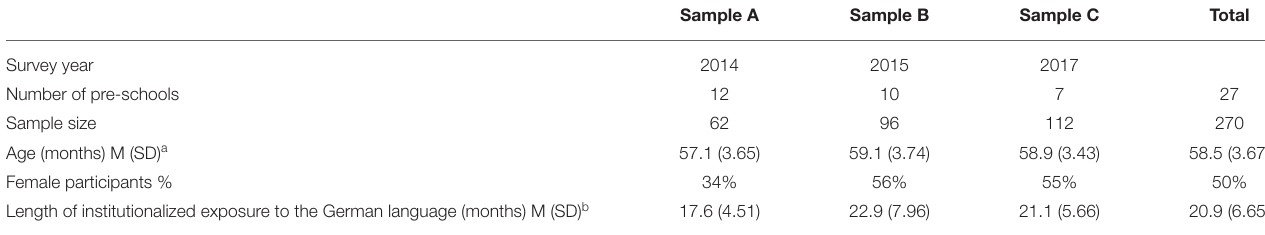
TABLE 1 | Sample description (family and child